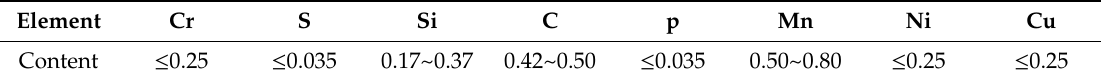
Figure 1. Scanning electron microscopy (SEM) micrograph of Ni60 powder. Table 1. Chemical composition of the 45# steel (wt.%).